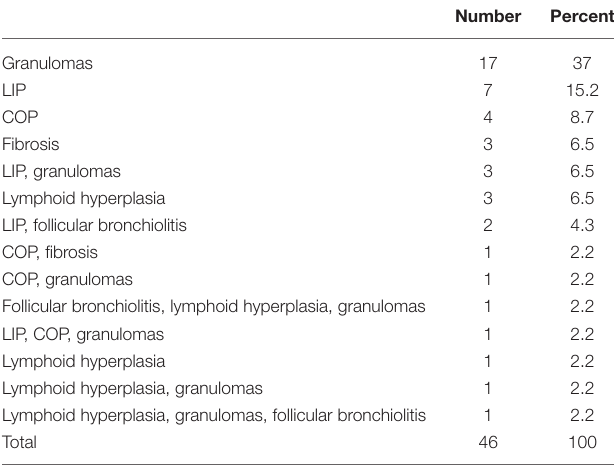
TABLE 3 | Lung pathology encountered in the CVID patients with ILD.